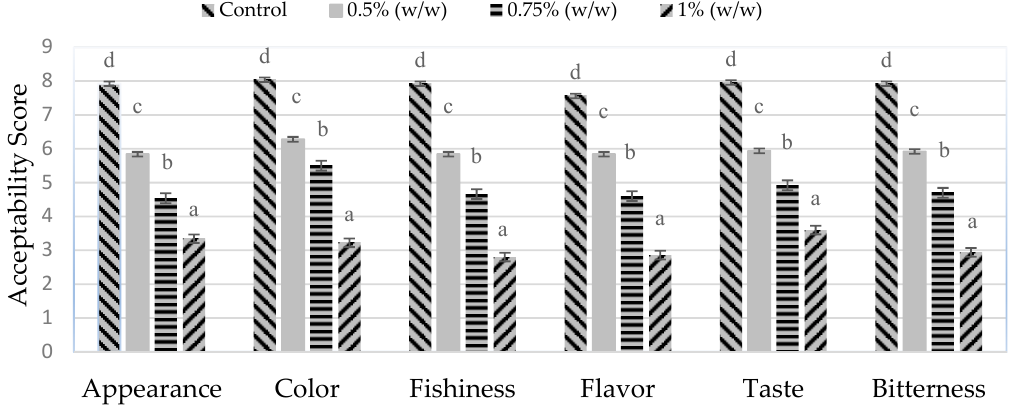
Figure 4. Sensory acceptability score of mango jelly product with and without TB hydrolysate. Different lowercase letters for the same attributes indicate significant differences ( p ≤ 0.05). Table 7. Antioxidant and ACE inhibitory activity of mango jelly with and without TB hydrolysate. Concentration DPPH (IC 50 ) Concentration (%)